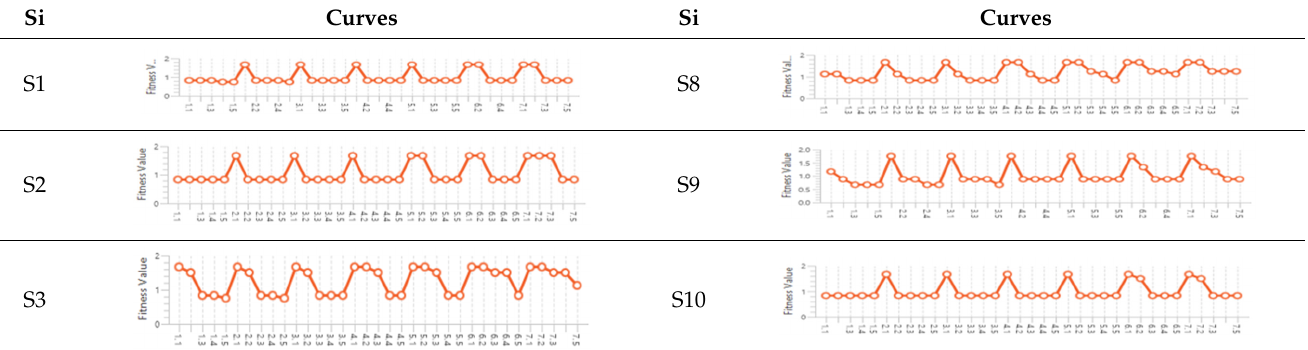
Table 2. Obtained results for the inputs of the test cases.